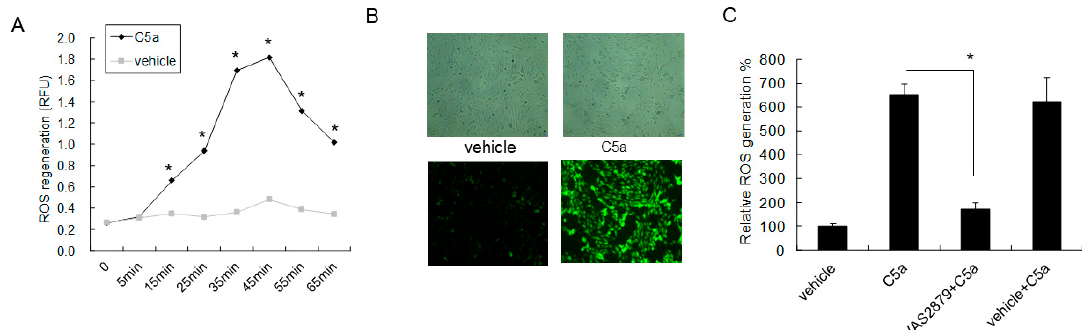
Figure 4. High-dose C5a treatment induced oxidative stress via NOXs-dependent reactive oxygen (ROS) generation in mouse KECs. ( A ) Mouse KECs were treated with vehicle or 50 ng / mL of rmC5a. The time sequence of ROS formation was detected by DCF-DA (Cellular Reactive Oxygen Species